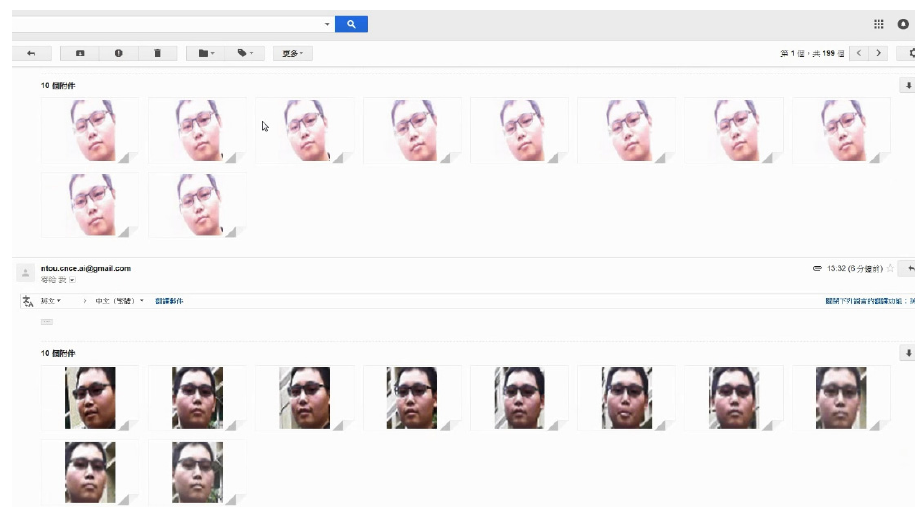
Figure 33. The control center received face pictures of the stranger.